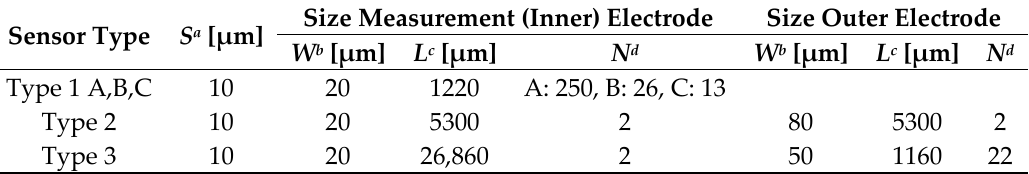
Figure 1. ( a ) Three designs for the microfabricated conductivity sensors. Sensor type 1 is a 2-electrode sensor, sensor type 2 and 3 are 4-electrode sensors. For the 4-electrode sensors the grey lines are the inner poles and the blue lines are the outer poles. The green hatched areas are the openings in the dielectric layer. ( b ) Microscope images of the fabricated sensors. Table 1. Geometry of the microfabricated conductivity